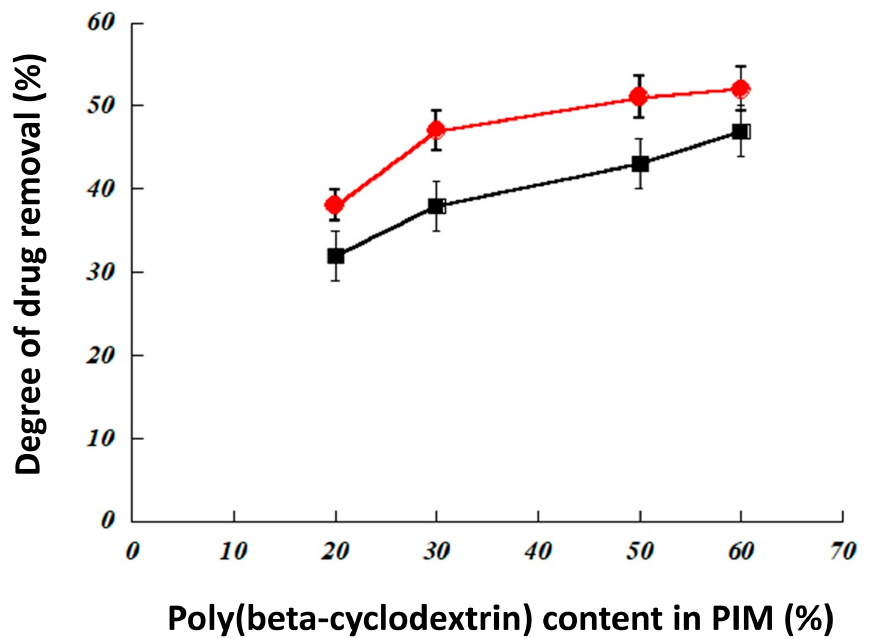
Figure 8. Influence of poly( β -cyclodextrin) content in the PVC/DBP/poly( β -cyclodextrin) membrane on the extraction of residual drug in wastewater. Two drugs were tested at an initial concentration of 10 ppm: ibuprofen (red circles) and progesterone (black squares). The extraction process was performed over 6 h. Each essay was performed in triplicate.